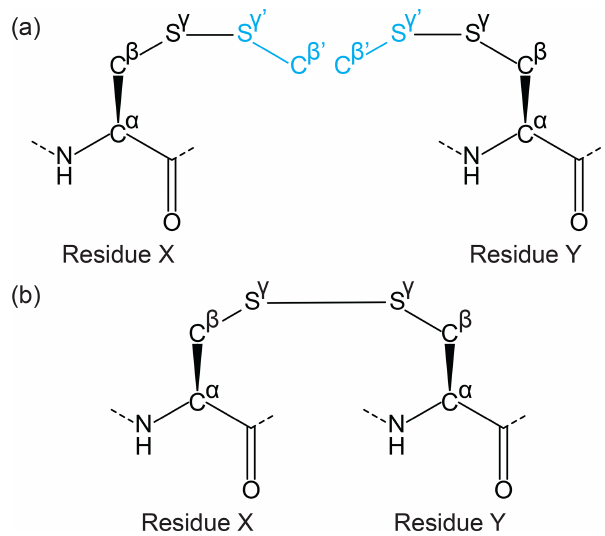
Figure 4. Example of a side-chain cyclisation using the Lib Linker for CYANA. Two extended ncAA template files are generated rep- resenting either side of the linkage (extension shown in cyan), in- cluding the linking atom and neighbouring atoms that define the chemical environment of the linked atoms. (a) For a disulfide bond, the linked residues are the same on either side, and a single template can be selected as both input files for Lib Linker (residues X and Y). Each side is, however, defined as having different positions in the peptide chain. The connecting atoms (S γ from each template) and overlap atoms (C β and S γ overlap with C β ’ and S γ ’ of the other template, shown in black and cyan respectively) are provided as user-defined input to Lib Linker. (b) Lib Linker generates two templates (identical in this case), where only the atoms from each side of the linking bond are included. Restraint files are also gener- ated that can be used directly for CYANA structure